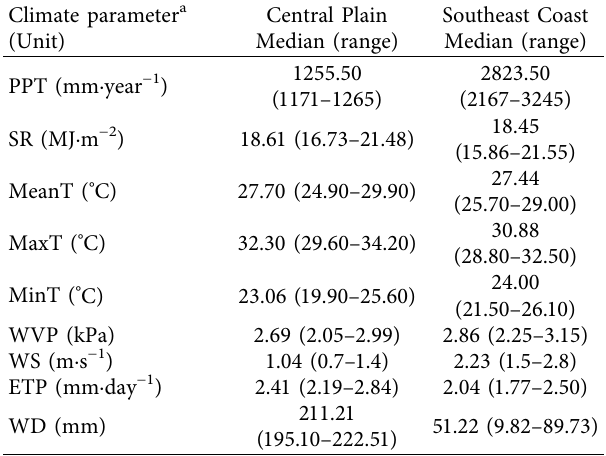
Table 5: Climate parameters of Central Plain and Southeast Coast. Climate parameter a